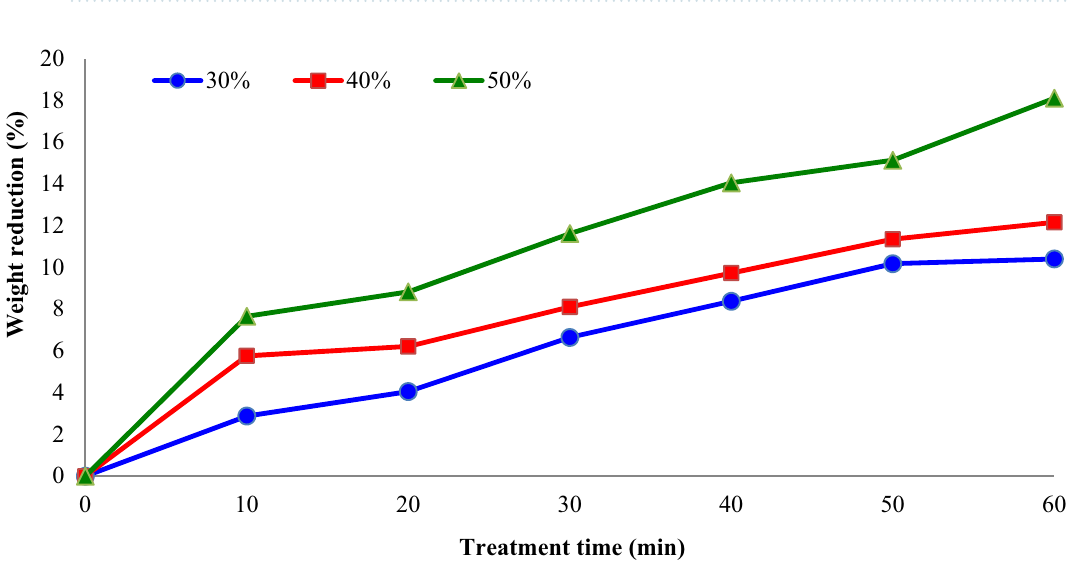
Figure 1. Impacts of sonication power and treatment time on the weight reduction (%) of apple slices during osmotic dehydration (concentration = 40° Brix).